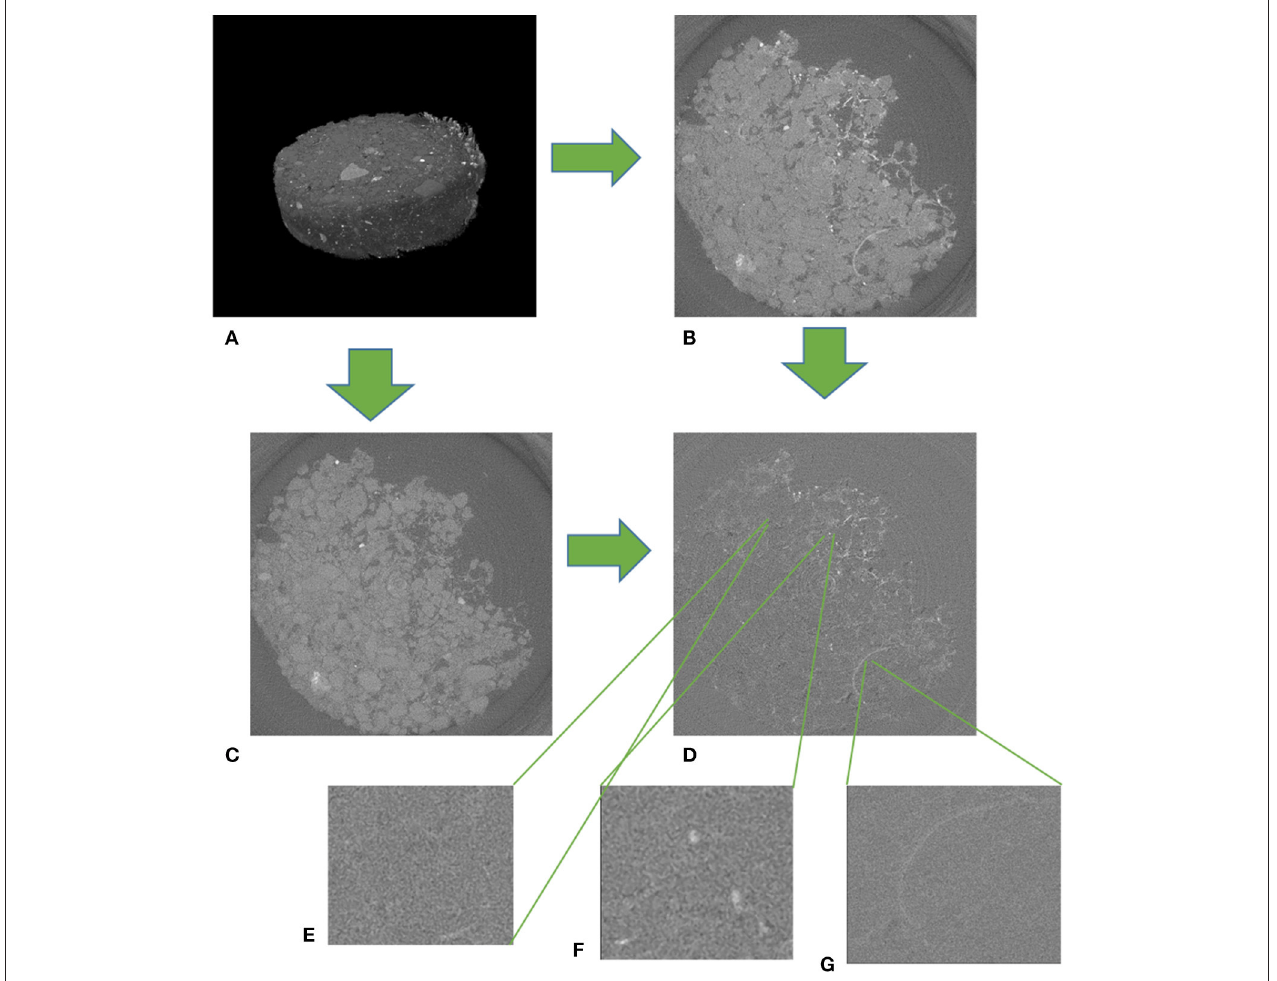
FIGURE 2 | An example of a µ CT image from an Os stained soil sample from biologically based management at 4 µ m resolution. (A) A 3D scan of an entire Os stained sample. The thickness of the sample was 1mm. (B) Image of a slice of an Os stained sample above the K-edge (74 keV). (C) Image of a slice of an Os stained sample below the K-edge (73.8 keV). (D) Difference between above and below K-edge images with non-biological pore (E) , POM-NS (G) , and POM-Root (F) expanded. Total image size is 8 × 8mm for (B–D)